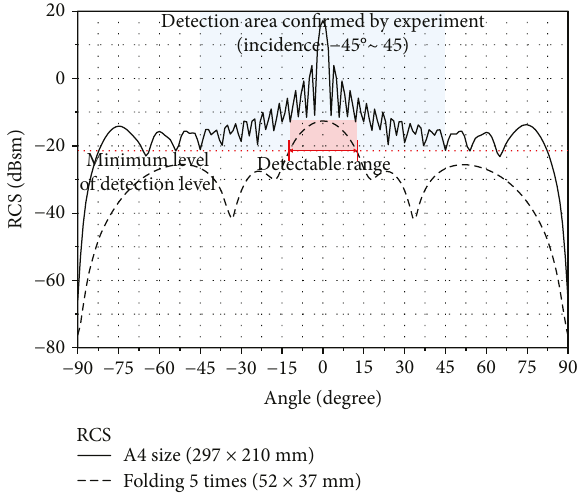
Figure 6: Simulated results of RCS analysis on PEC plate size